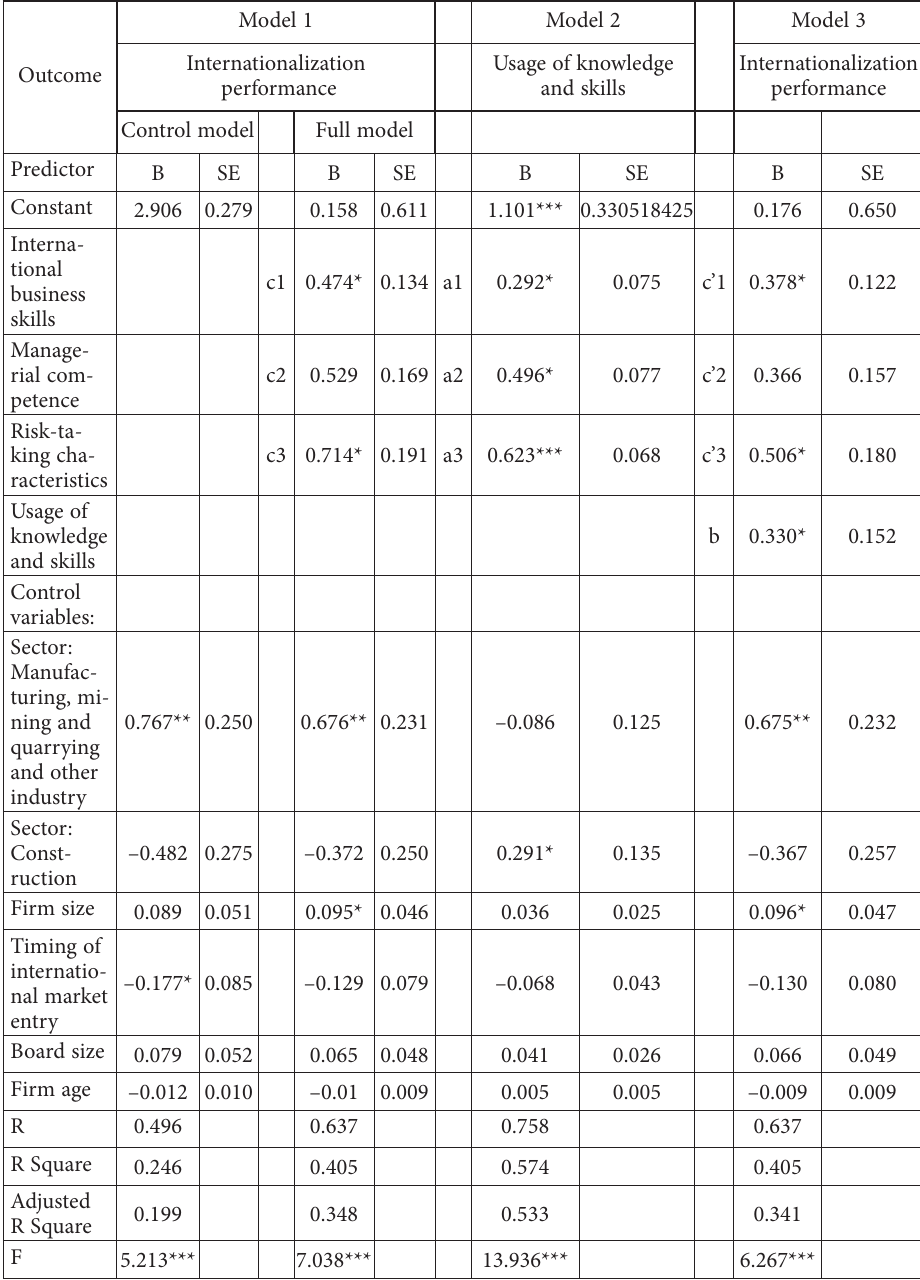
Table 2. OLS regression models for board’s characteristics and internationalization performance with unstandardized coefficients (source: own